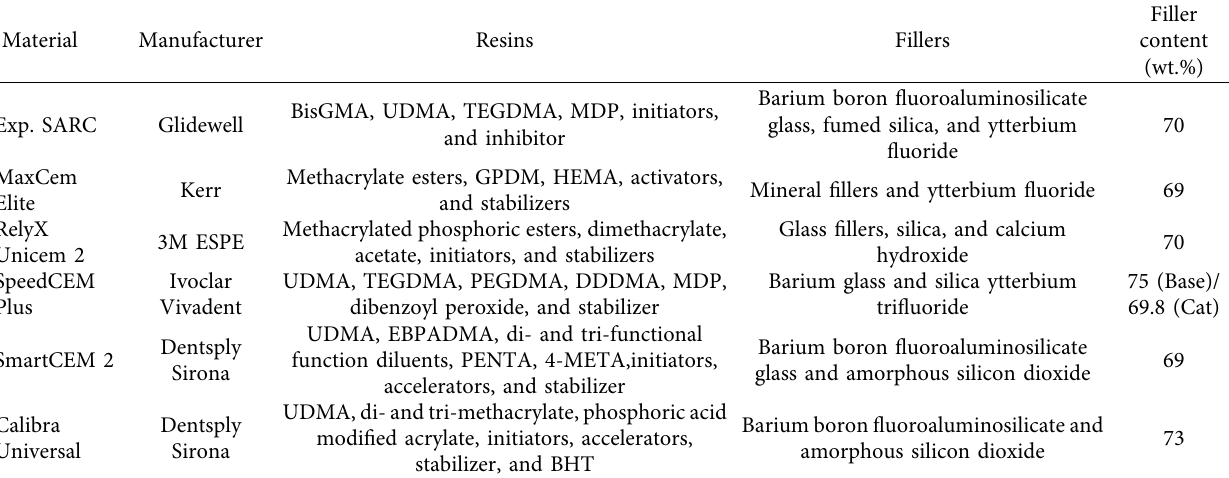
Table 1: Self-adhesive resin cements used in this